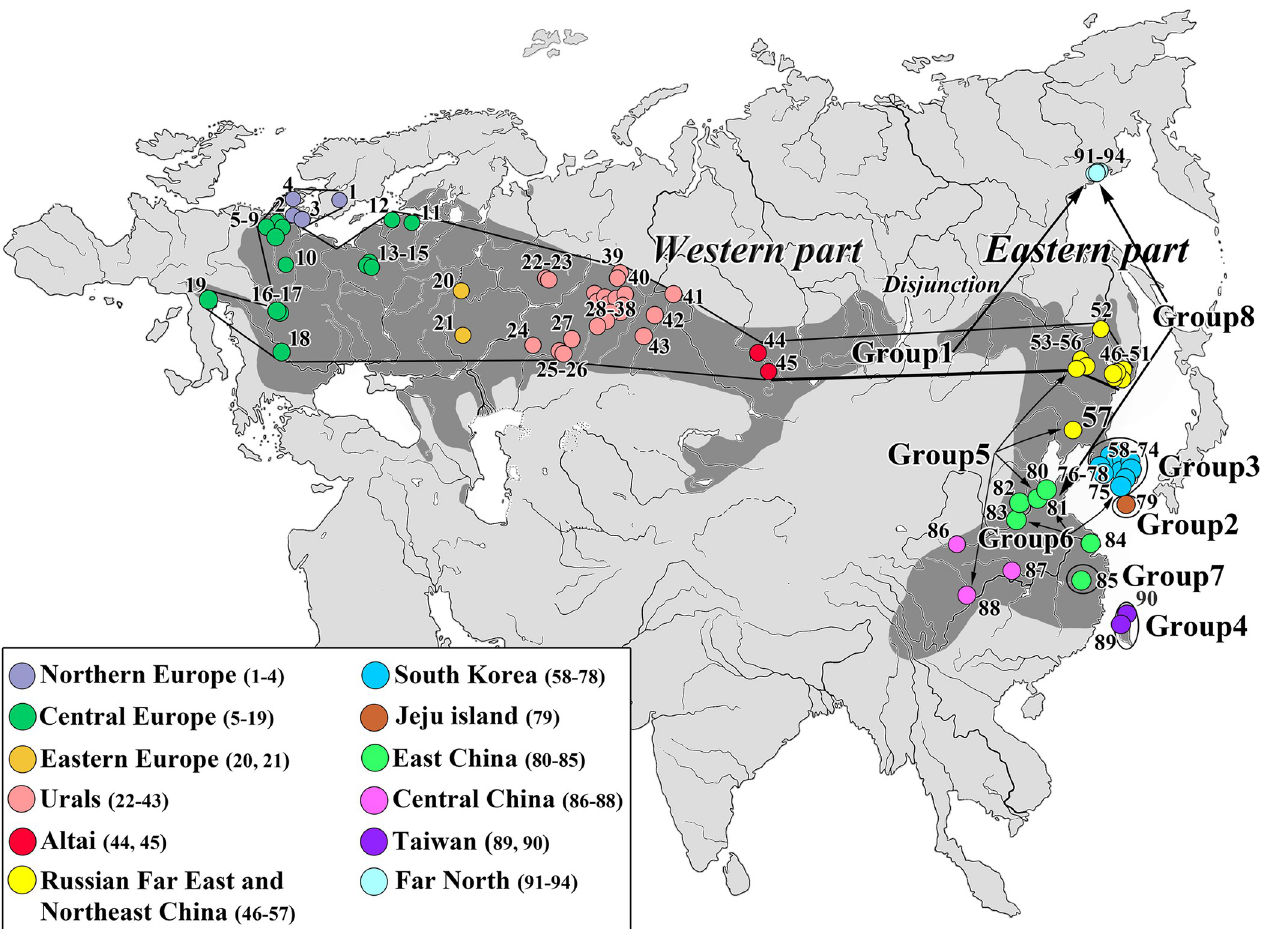
Fig 1. A . agrarius range (dark grey area) and localization of samples used in the study. The numbers of localities correspond to those given in Table